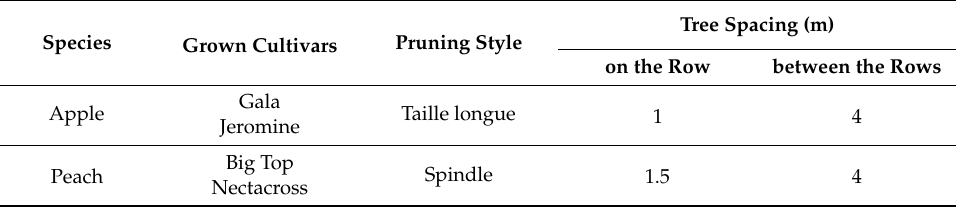
Table 2. Characteristics of the two fields where test have been carried out.